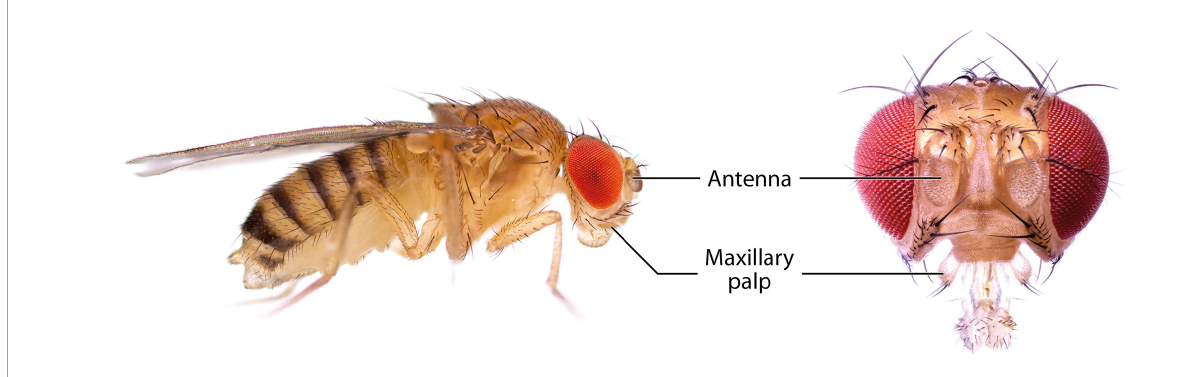
FIGURE1 Photographs of D. melanogaster showing the main olfactory organs, the antennae and the maxillary palps.